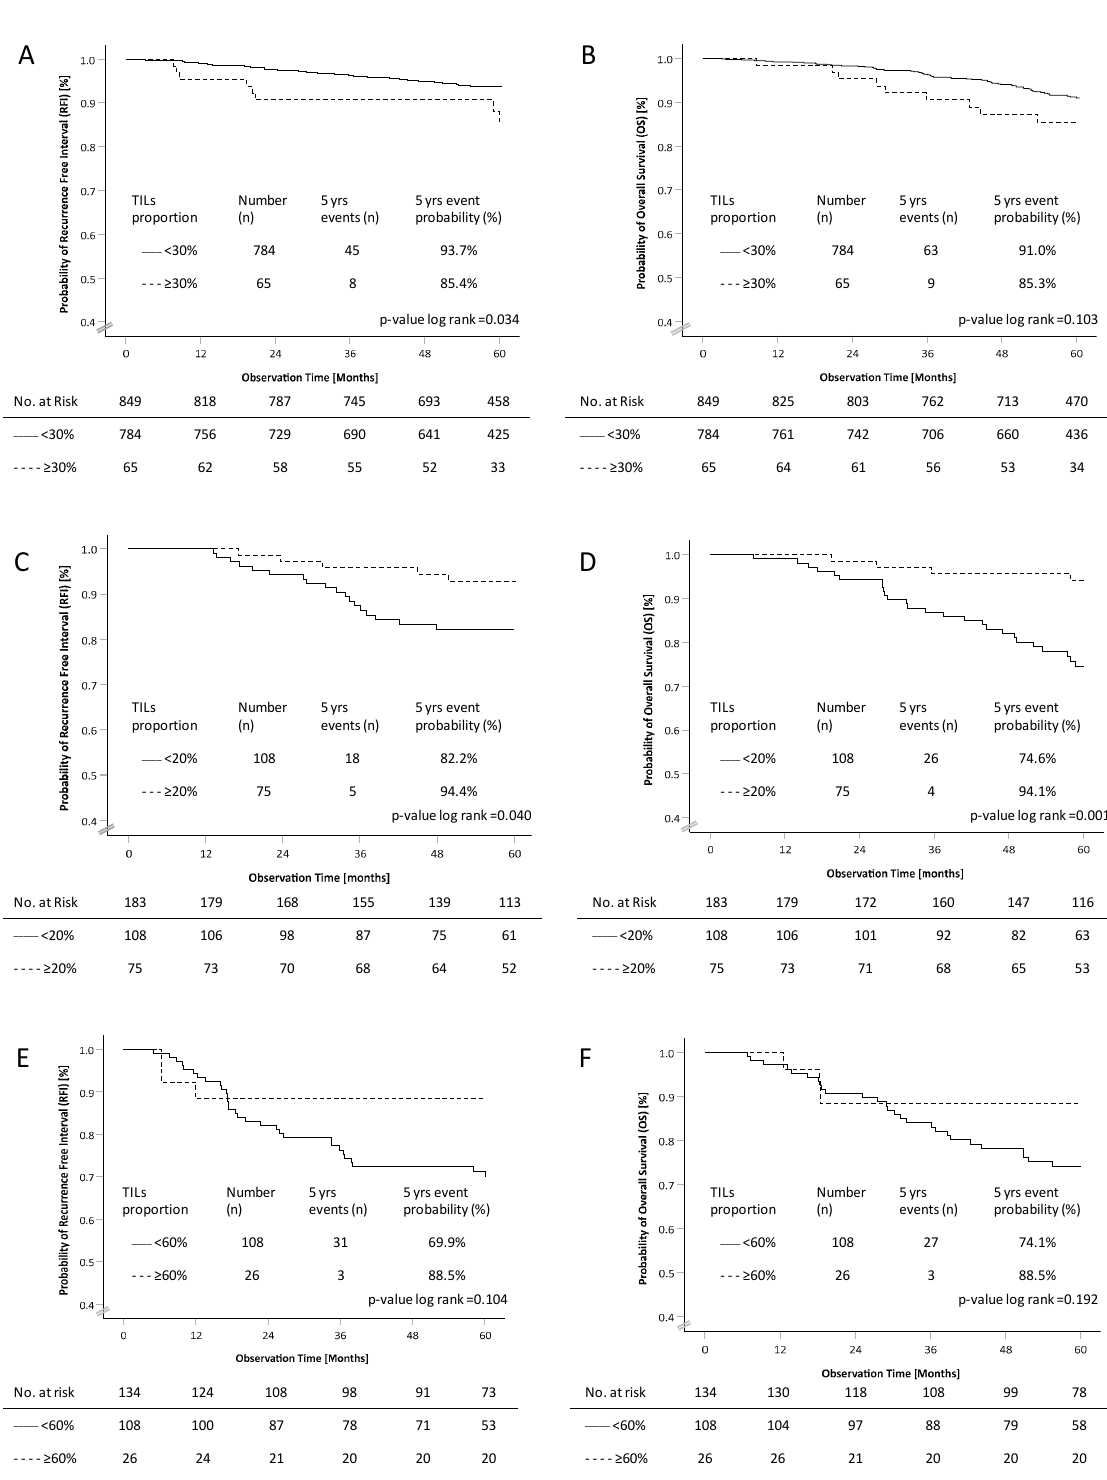
Figure 4. Kaplan–Meier plots for patients in the TILs groups with their cut-offs for the HR-pos and HER2-neg RFI ( A ) and OS ( B ), HER2-pos and any HR RFI ( C ) and OS ( D ), and TNBC RFI ( E ) and OS ( F ); the tables present the effective sample size for each interval (no. at risk).